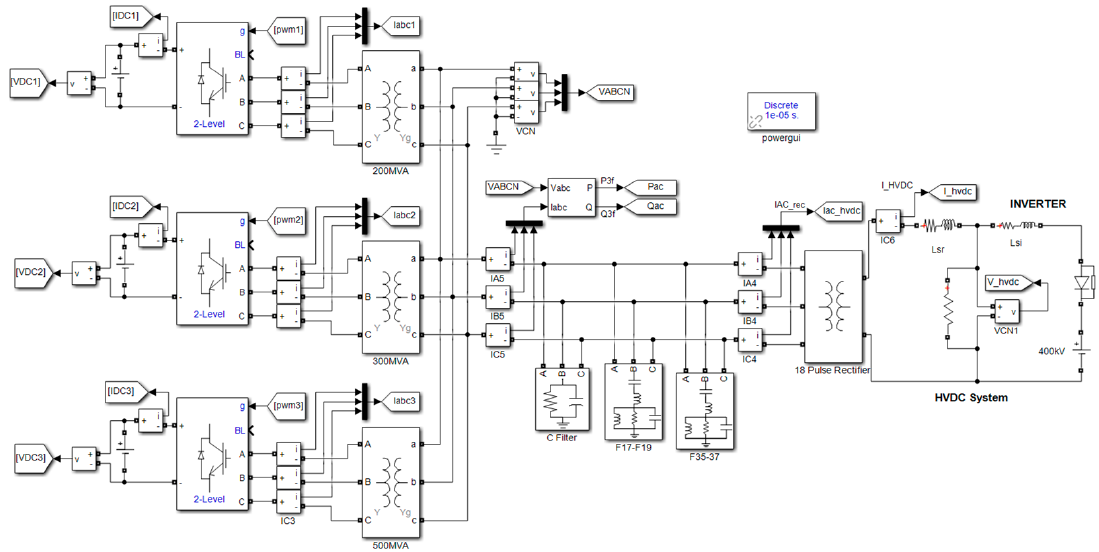
Figure 13. The simulated wind generation system.